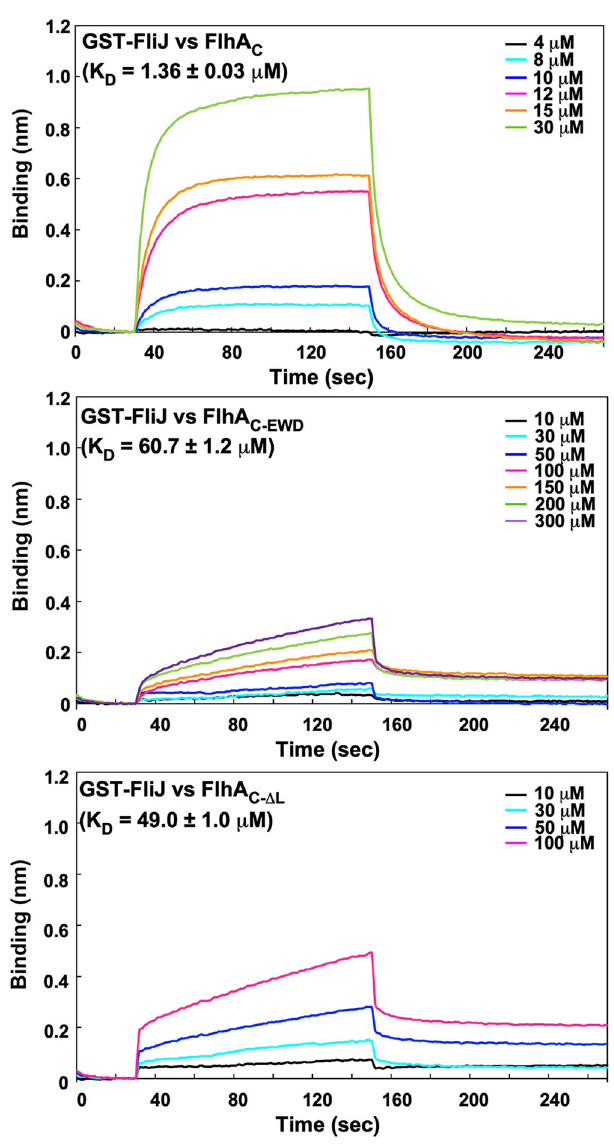
Fig. 3 Effect of FlhA linker mutations on the interaction of FlhA C with FliJ. BLI pro fi les were obtained from the FlhA C – FliJ interaction (1st row), the FlhA C-EWD – FliJ interaction (2nd row), and the FlhA C- Δ L – FliJ interaction (3rd row). GST-FliJ was immobilized to an anti-GST sensor tip. The sensor tip was then dipped into FlhA C , FlhA C-EWD , or FlhA C- Δ L of various concentrations to measure association before being dipped into the kinetic buffer to measure dissociation. Three independent measurements were carried out. All experiments were performed at 25 FlhA C with the fl hA EWD mutation (FlhA C-EWD ) or FlhA C lacking FlhA L (FlhA C- Δ L ) were observed only at protein concentrations above 10 μ M (Fig. 3, 2nd and 3rd rows). Their association and dissociation processes were also different from those of wild-type FlhA C . The association pro fi le of these mutant proteins was composed of two distinct (fast-on and slow-on) processes, and the dissociation pro fi le was also composed of two distinct (fast-off and slow-off) processes. It has been shown that wild-type FlhA C forms dimer in a protein concentration-dependent manner and that FlhA L is required for ef fi cient dimerization of FlhA C 27 . So, their BLI data were fi tted well with curves predicted by the Hill equation, with K D values of 60.7 ± 1.2 μ M ( n = 3) and 49.0 ± 1.0 μ M ( n = 3) for the FliJ – FlhA – FlhA C-EWD and FliJ C- Δ L